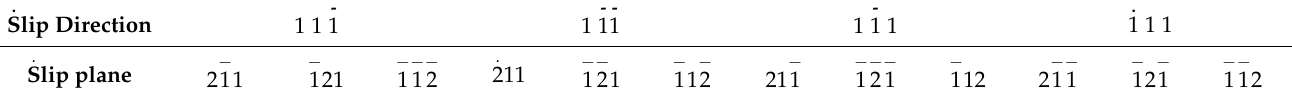
Table 2. {112} <111> slip